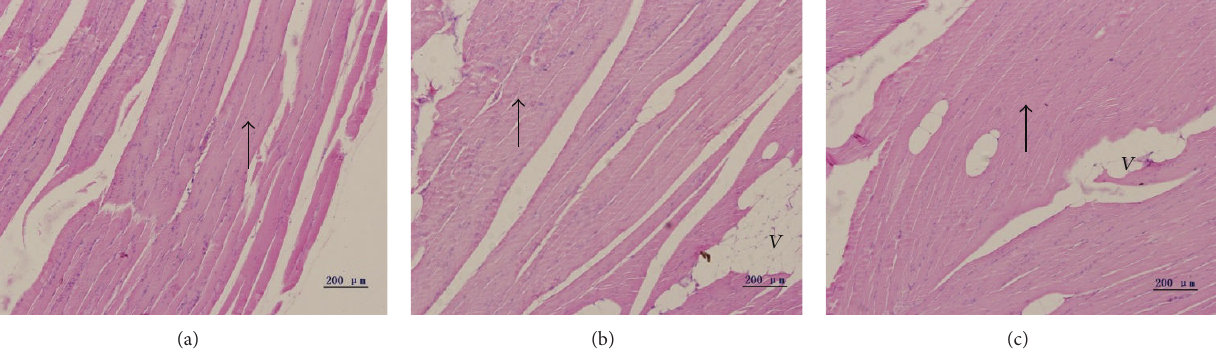
Figure 1: (a) Normal myofibril of skeletal muscle in normal mice, HE × 200. (b) Atrophic myofibril of skeletal muscle in diabetic model mice, HE × 200. (c) Improved myofibril of skeletal muscle after liraglutide injected for 6 weeks, HE × 200. Black arrow : myofibril, V : vacuoles.